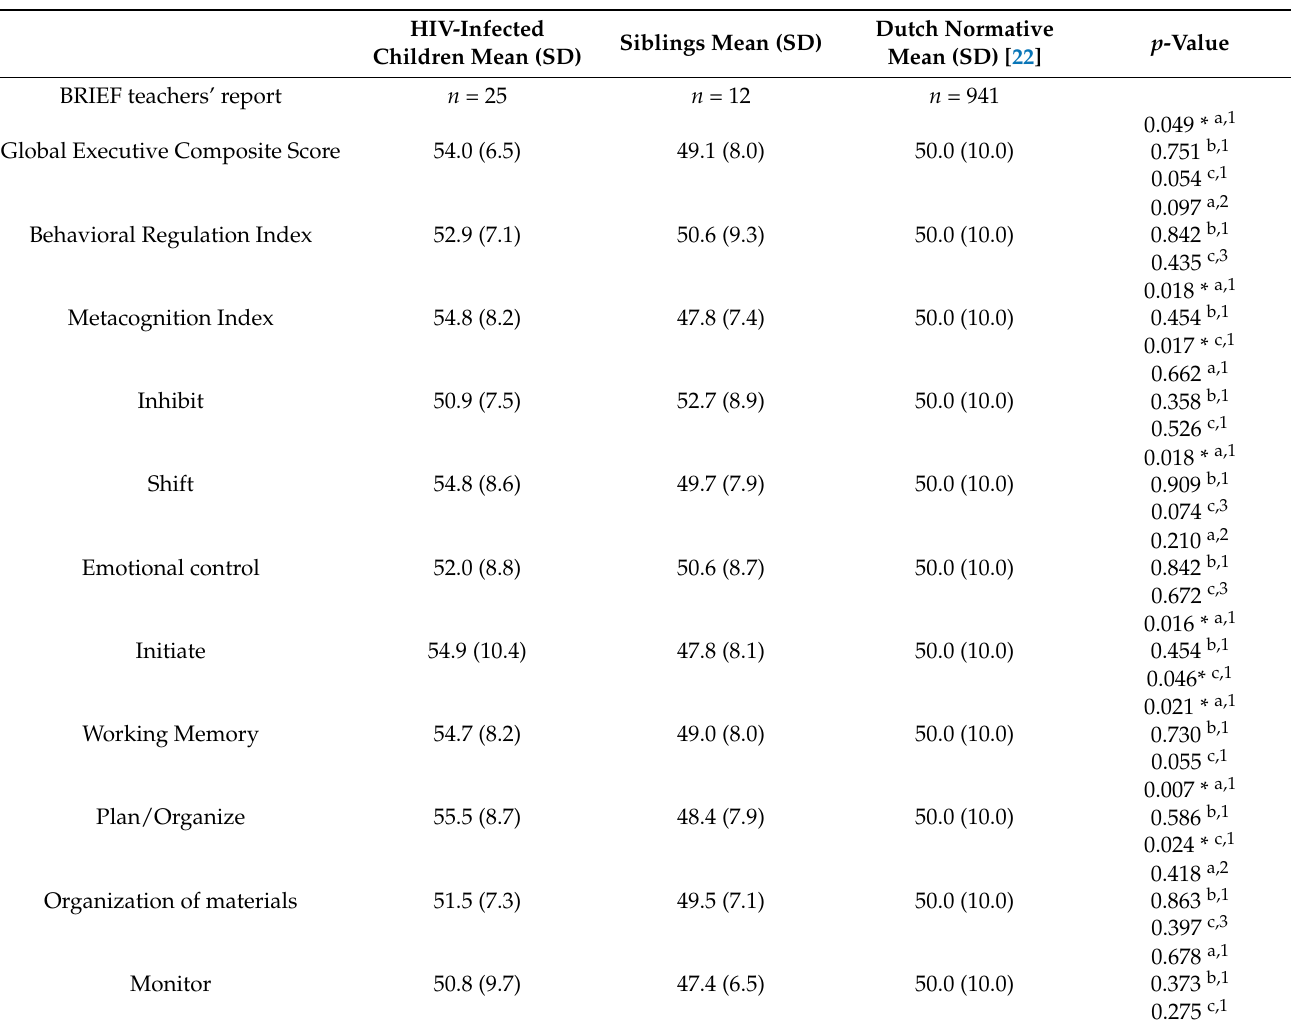
Table 3. Results BRIEF teachers’